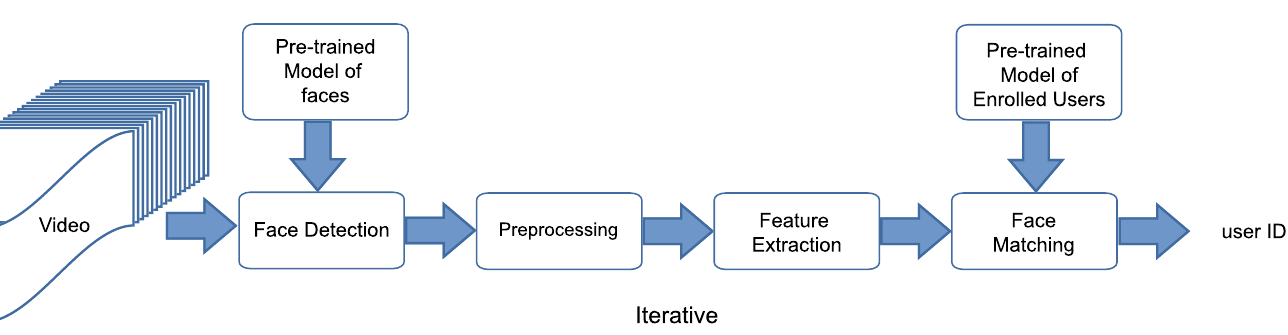
Figure 2. General real-time face recognition framework in video systems.